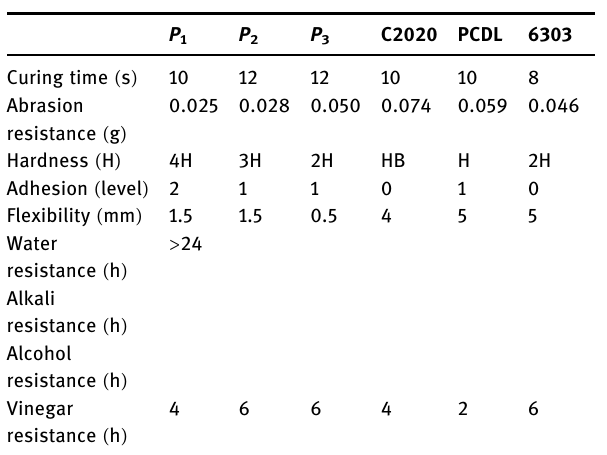
Table 2: The in fl uence of di ff erent PUA types on the properties of UV - cured coating fi lm